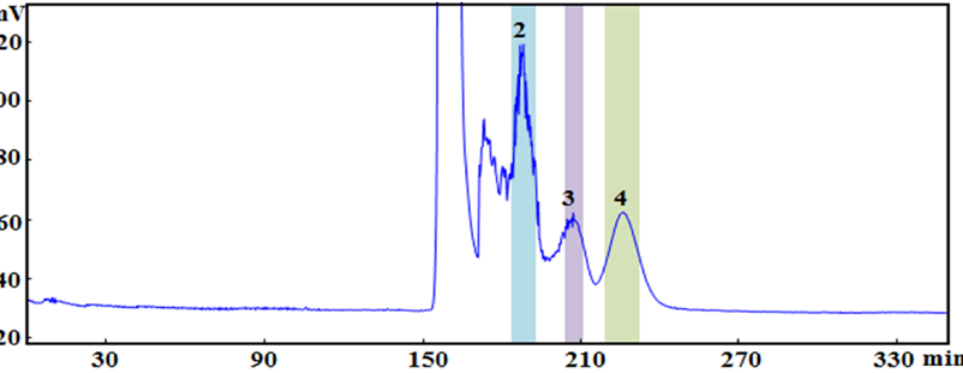
Figure 4. High − speed counter current chromatography (HSCCC) of the P.cocos extract. (solvent system: PET: EtOAc : MeOH : H 2 O (4.0:1.0:3.0:2.0, v/v/v/v ); coiled column: 800 rpm; detection wavelength: 270 nm. Compounds: (2) Polyporenic acid C; (3) 3 − Epidehydrotumulosic acid; (4) Pachymic acid).